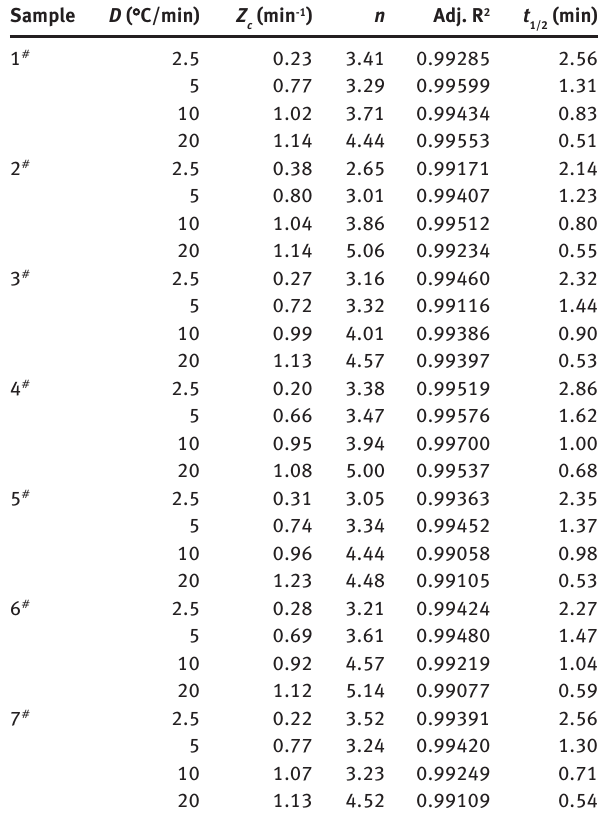
Table 1 Non-isothermal crystallization kinetic parameters of the PP/ZnO samples based on